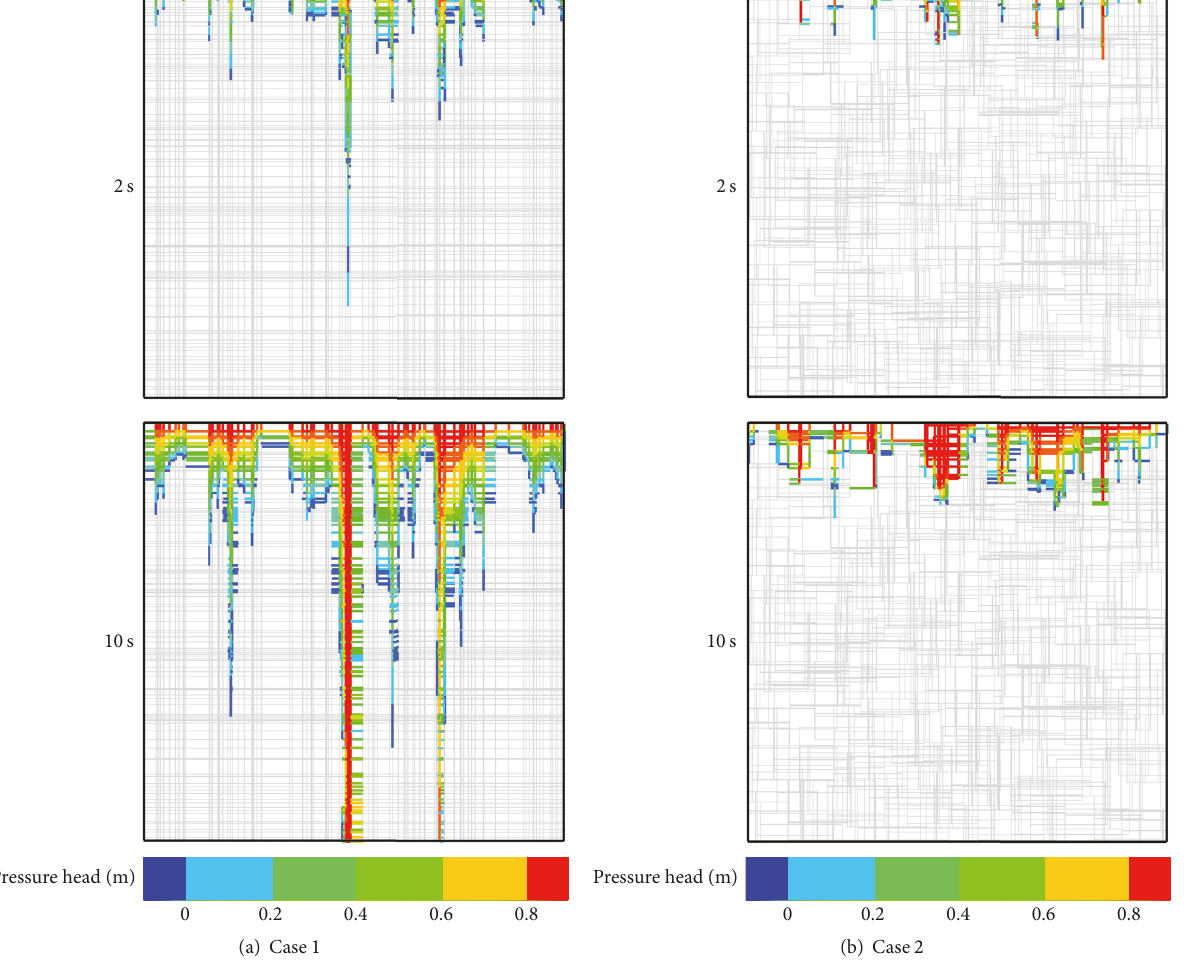
Figure 8: Variation of water seepage in the two fracture systems at times 2s and 10